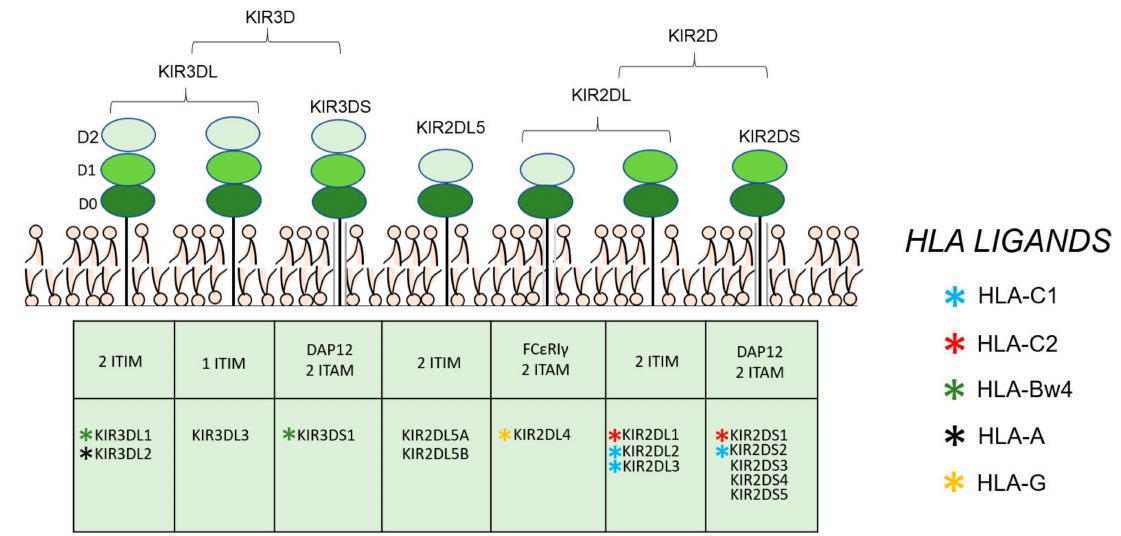
Figure 2. KIR protein structures and ligands. Individual KIR ligands are shown in small asterisks of di ff erent colors (KIR ligands for KIR3DL3, KIR2DL5, KIR2DS3, and KIR2DS5 are